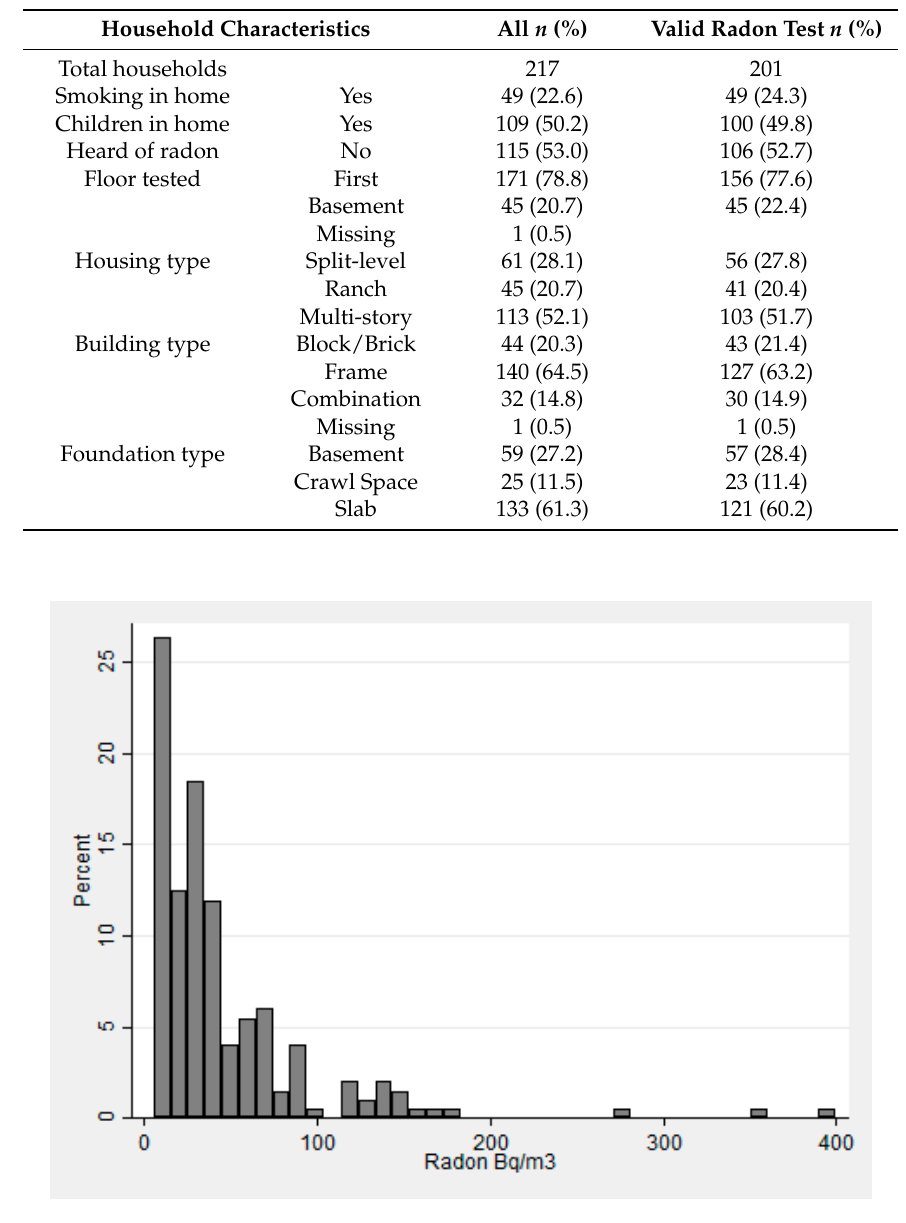
Figure 1. Histogram of radon results from homes tested in the DeKalb County pilot study in 2015.